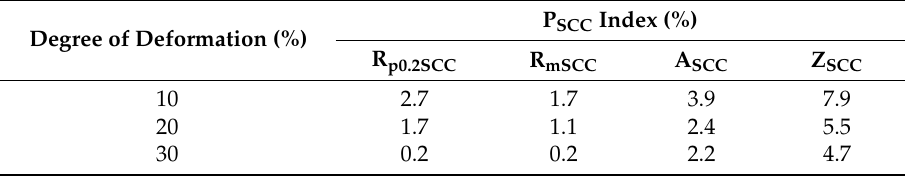
Table 4. P SCC indices for the investigated alloy after